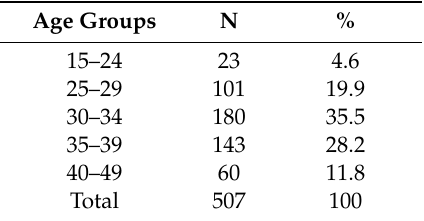
Table 1. Study population by age groups; Apulia, Southern Italy, 2016–2019.